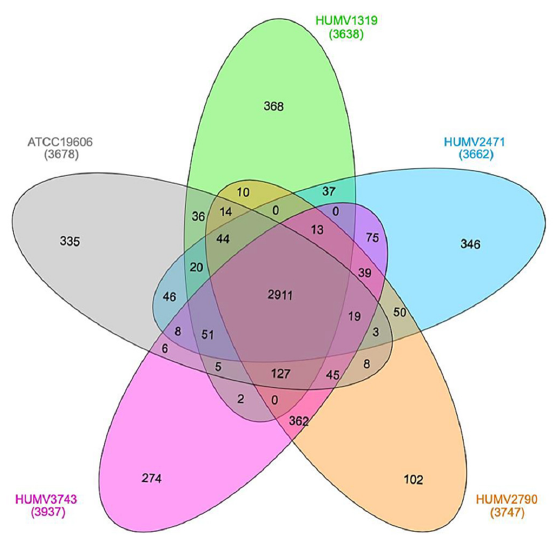
Figure 3. Venn diagram with pan-genome composition of five A. baumannii strains. In the middle, core-genome size. Each value corresponds with the number of CDS shared for two or more strains, and the single ones in the end of each ellipse.